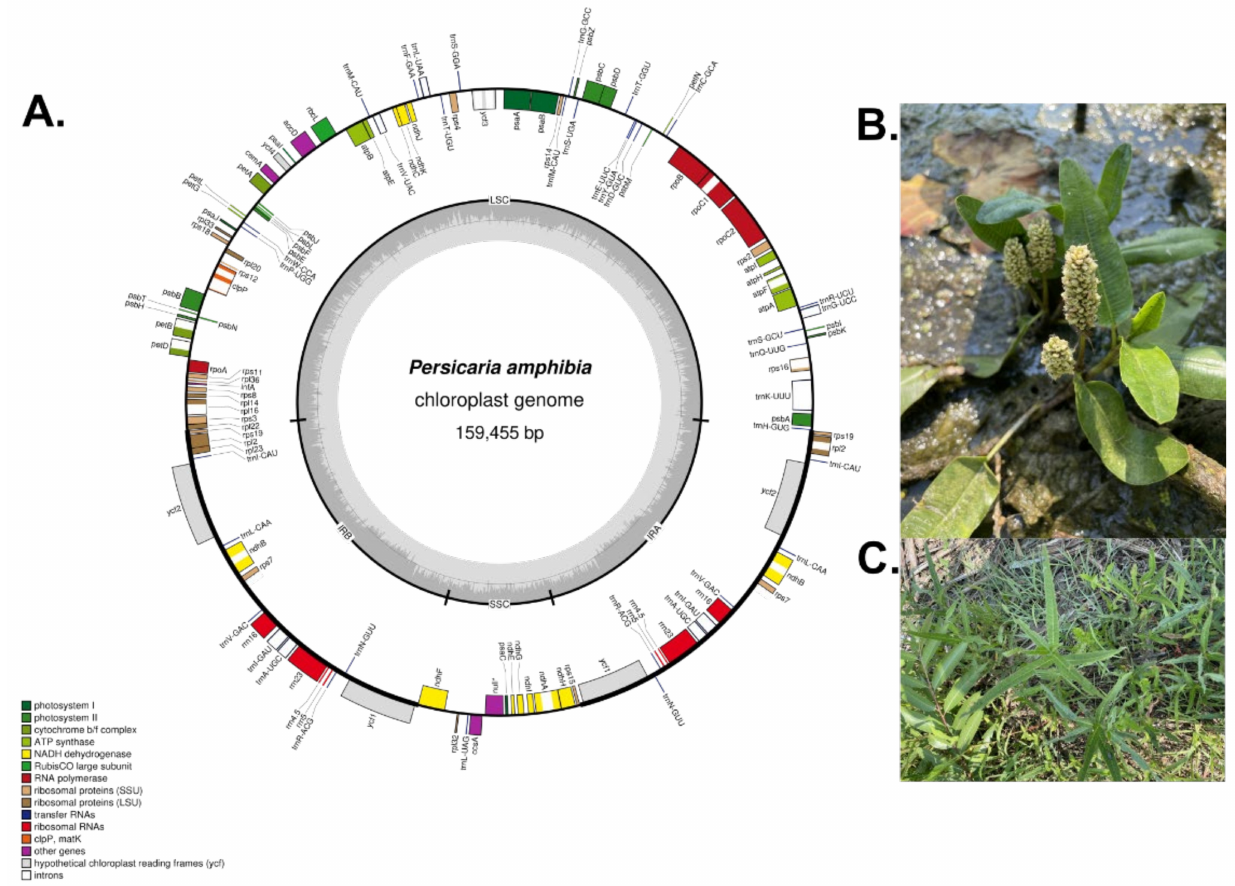
Figure 1. The complete chloroplast genome of P. amphibia ( A ). Genes drawn inside the circle are transcribed clockwise, and those outside are counterclockwise. The darker gray in the inner circle corresponds to GC contents. Aquatic form of P. amphibia ( B ) and terrestrial form of P. amphibia ( C ). Fifteen genes ( rps16 , atpF , rpoC1 , petB , petD , rpl16 , rpl2 , ndhB , ndhA , trnA -UGC, trnI - GAU, trnV -UAC, trnL -UAA, trnG -UCC, and trnK -UUU) had one intron, whereas three genes ( ycf3 , clpP , and rps12 ) contained two